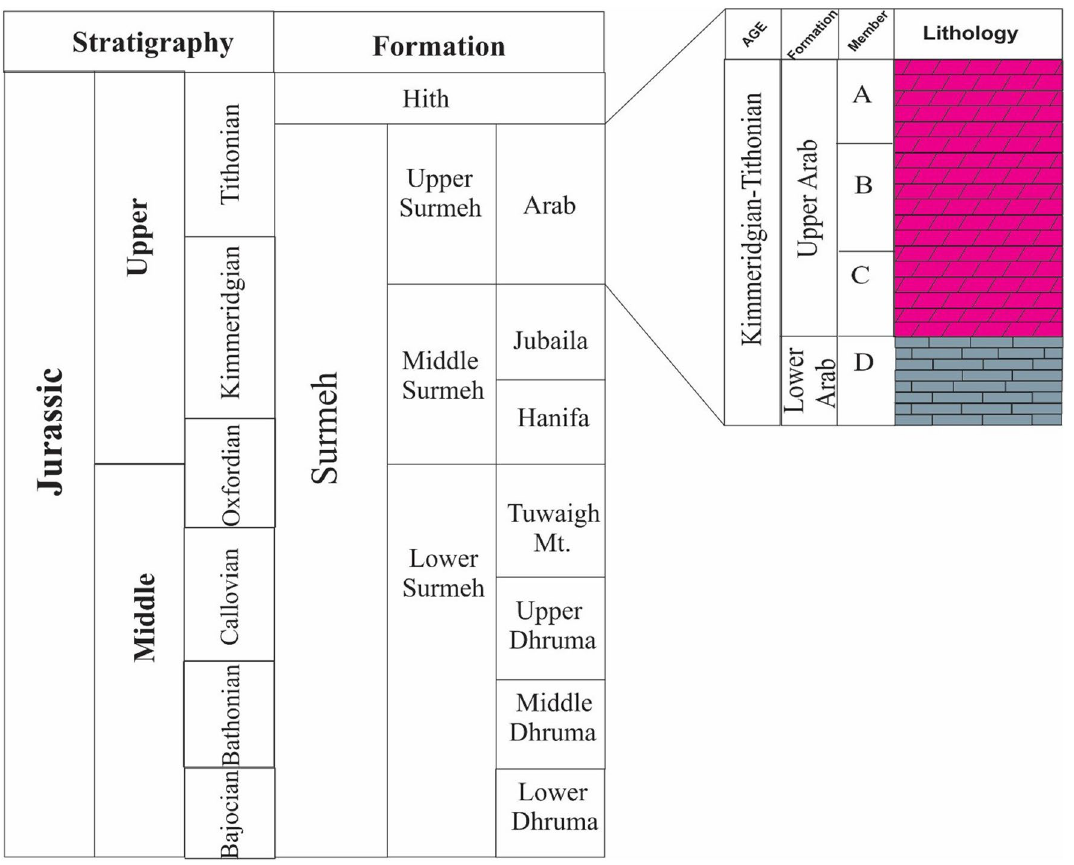
Fig. 2 Stratigraphy column of the Jurassic successions including the Arab